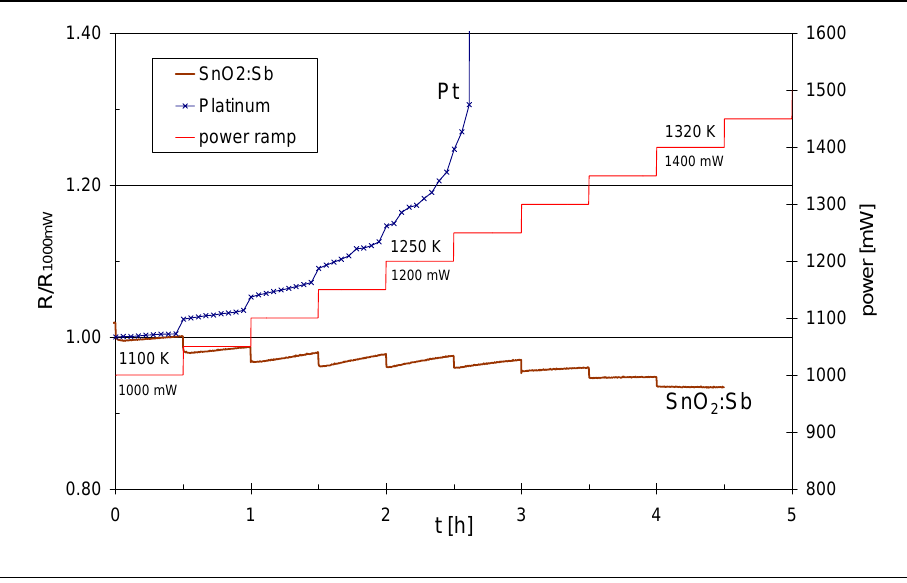
Figure 6. Accelerated aging tests of Pt (upper curve) and SnO :Sb (lower curve) heater elements in air. 2 Increased temperature (el. input power) leads to a rapidly increasing Pt degradation, whereas SnO :Sb 2 emitters can be operated up to temperatures in the 1300 K range demonstrating the superior performance of SnO :Sb based heater elements. The seeming instability at lower temperatures is due to 2 adsorption/desorption effects at the SnO :Sb 2